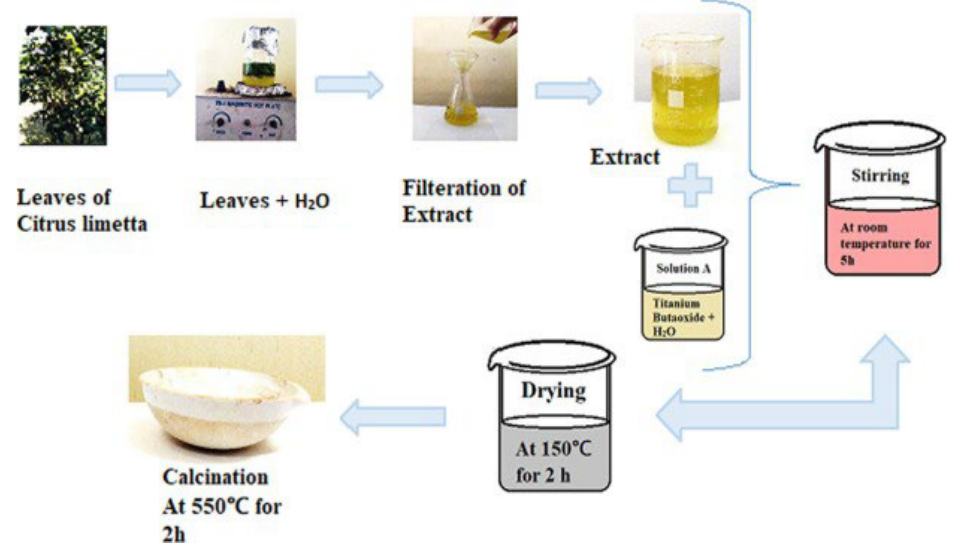
Figure 16. Flowchart of the synthesis of TiO 2 nanoparticles. Reprinted from [60].